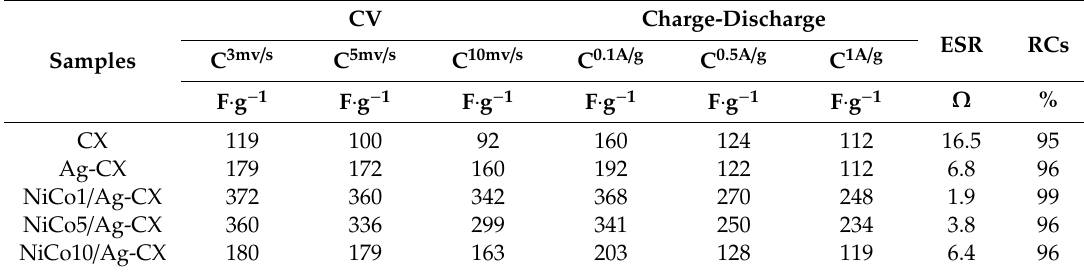
Table 3. Specific capacitances calculated from CV and galvanostatic charge-discharge. Capacitance retention (RCs) and equivalent series resistance (ESR) calculated from